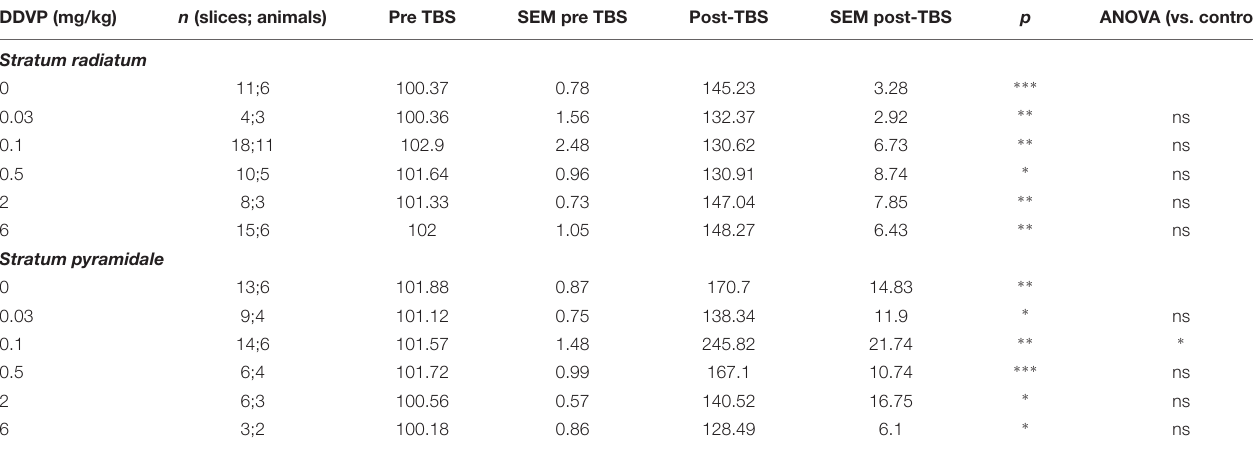
TABLE 1 | Effect of various doses of sub-chronic DDVP treatment on long-term potentiation recorded ex vivo in the stratum radiatum or stratum pyramidale of the CA1 area of rat hippocampal slices. DDVP (mg/kg) n (slices; animals) Pre TBS SEM pre TBS Post-TBS SEM post-TBS p ANOVA (vs. control)